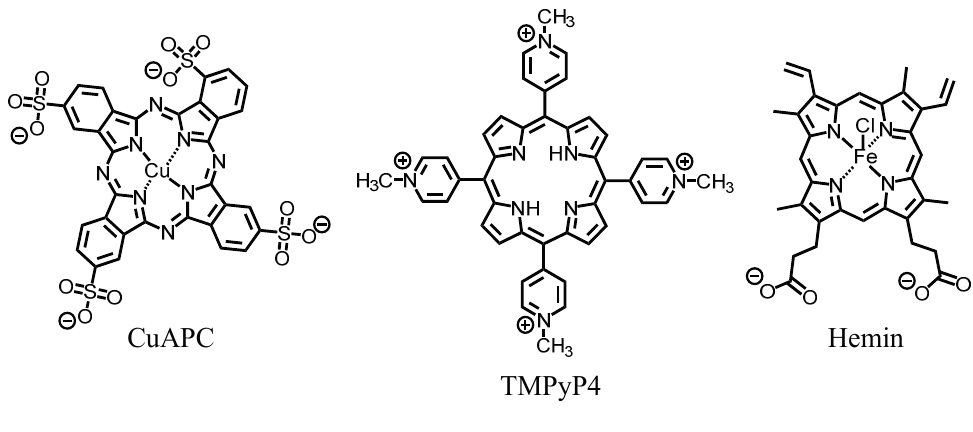
Figure 4. Chemical structures of CuAPC, TMPyP4, and